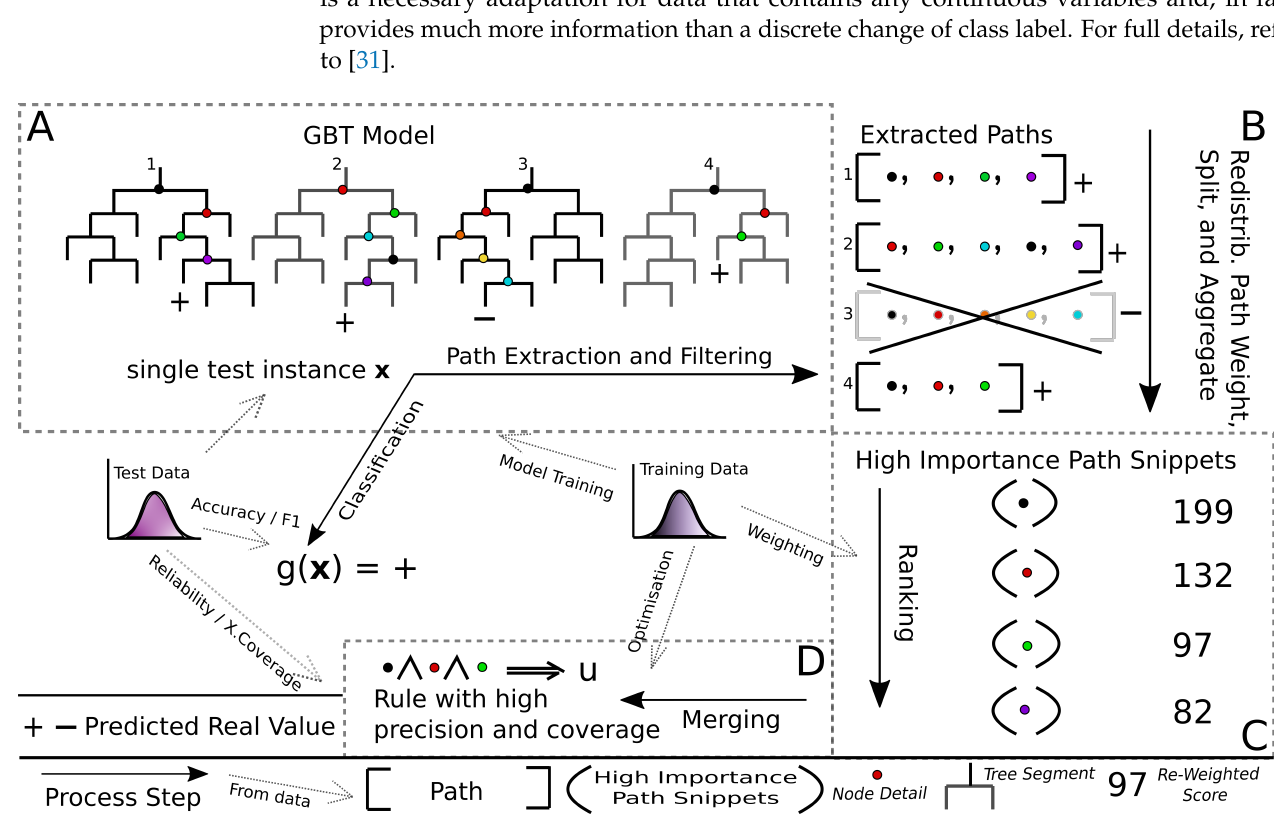
Figure 1. Conceptual diagram of Gradient Boosted Trees High Importance Path Snippets (gbt-HIPS). There are four steps: ( A ) path extraction and filtering, ( B ) decompose the paths and redistribute the predicted logit values among the nodes, ( C ) scoring and ranking, ( D ) merging and